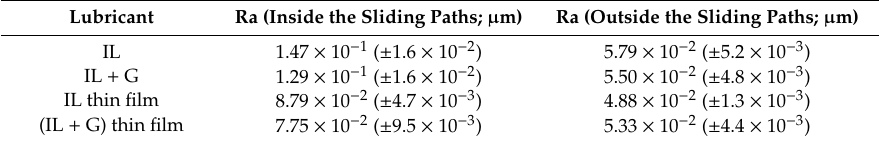
Table 3. Average roughness (Ra) values for AISI 316L disks surface after the tribological tests. Lubricant Ra (Inside the Sliding Paths; μm)